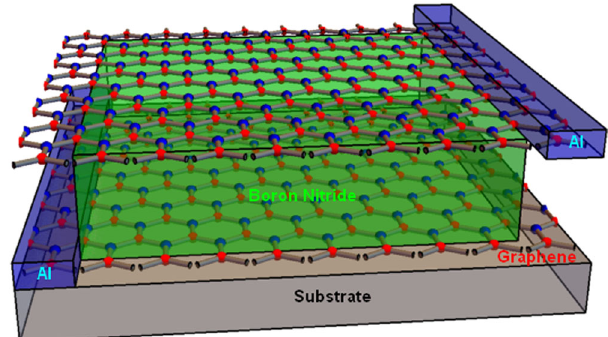
Fig. 1 Schematics of the proposed layered structure